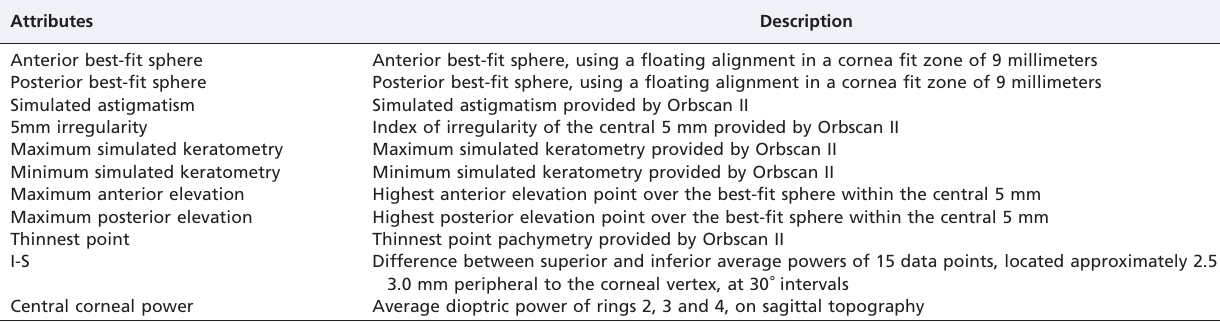
Table 1 - Attributes used as input data for the machine learning classifiers. Attributes Description Anterior best-fit